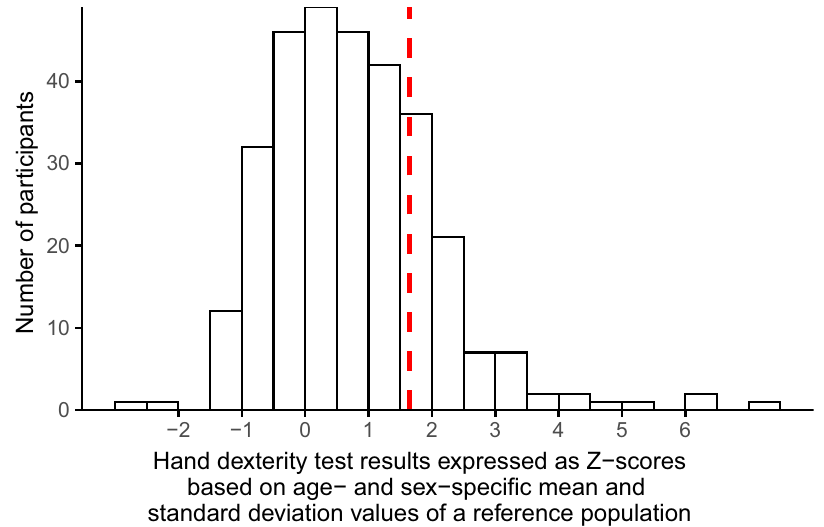
Figure 1. Distribution of Z-scores of the time required to perform the hand dexterity test calculated based on age- and sex-specific mean and standard deviation values of a reference population. The dashed line represents the age- and sex-specific mean + 1.645 times the age- and sex-specific standard deviation of a reference population, which translates to the 95th percentile of the age- and sex-specific reference population 12 . Participants right to this line were defined as having an impaired hand